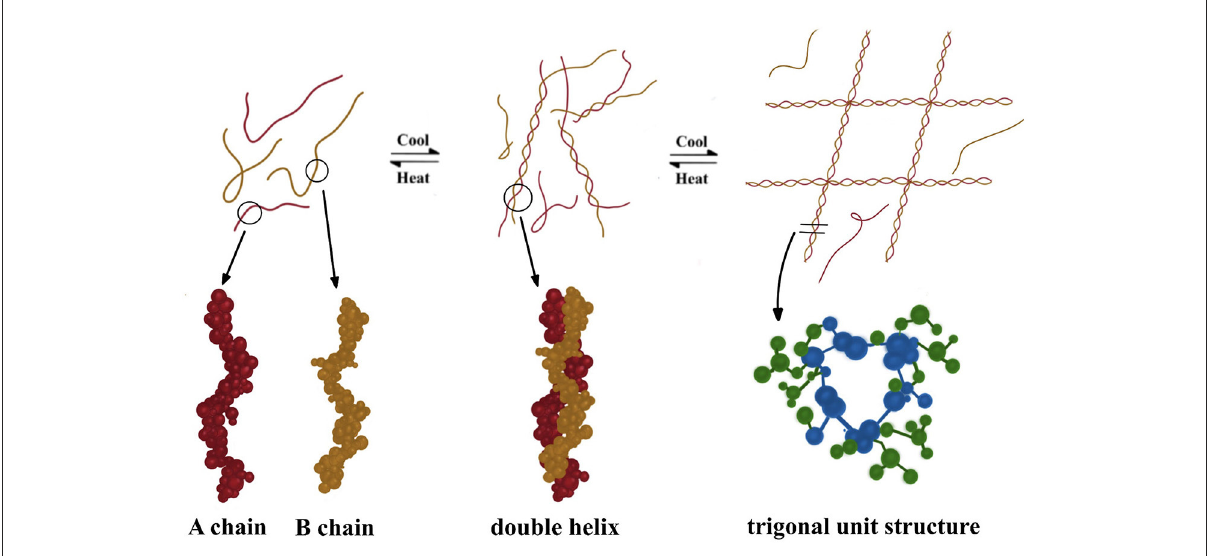
FIGURE4 Schematic diagram of the carrageenan film forming